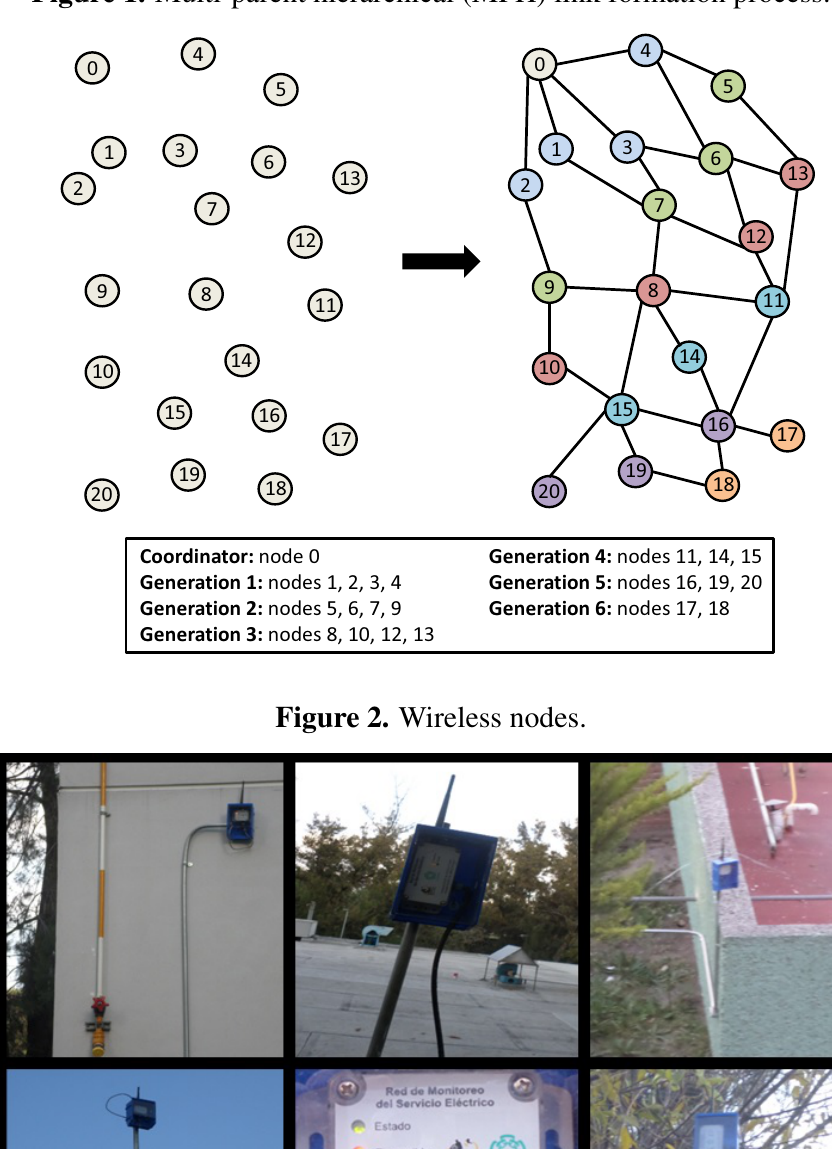
Figure 1. Multi-parent hierarchical (MPH) link formation process.